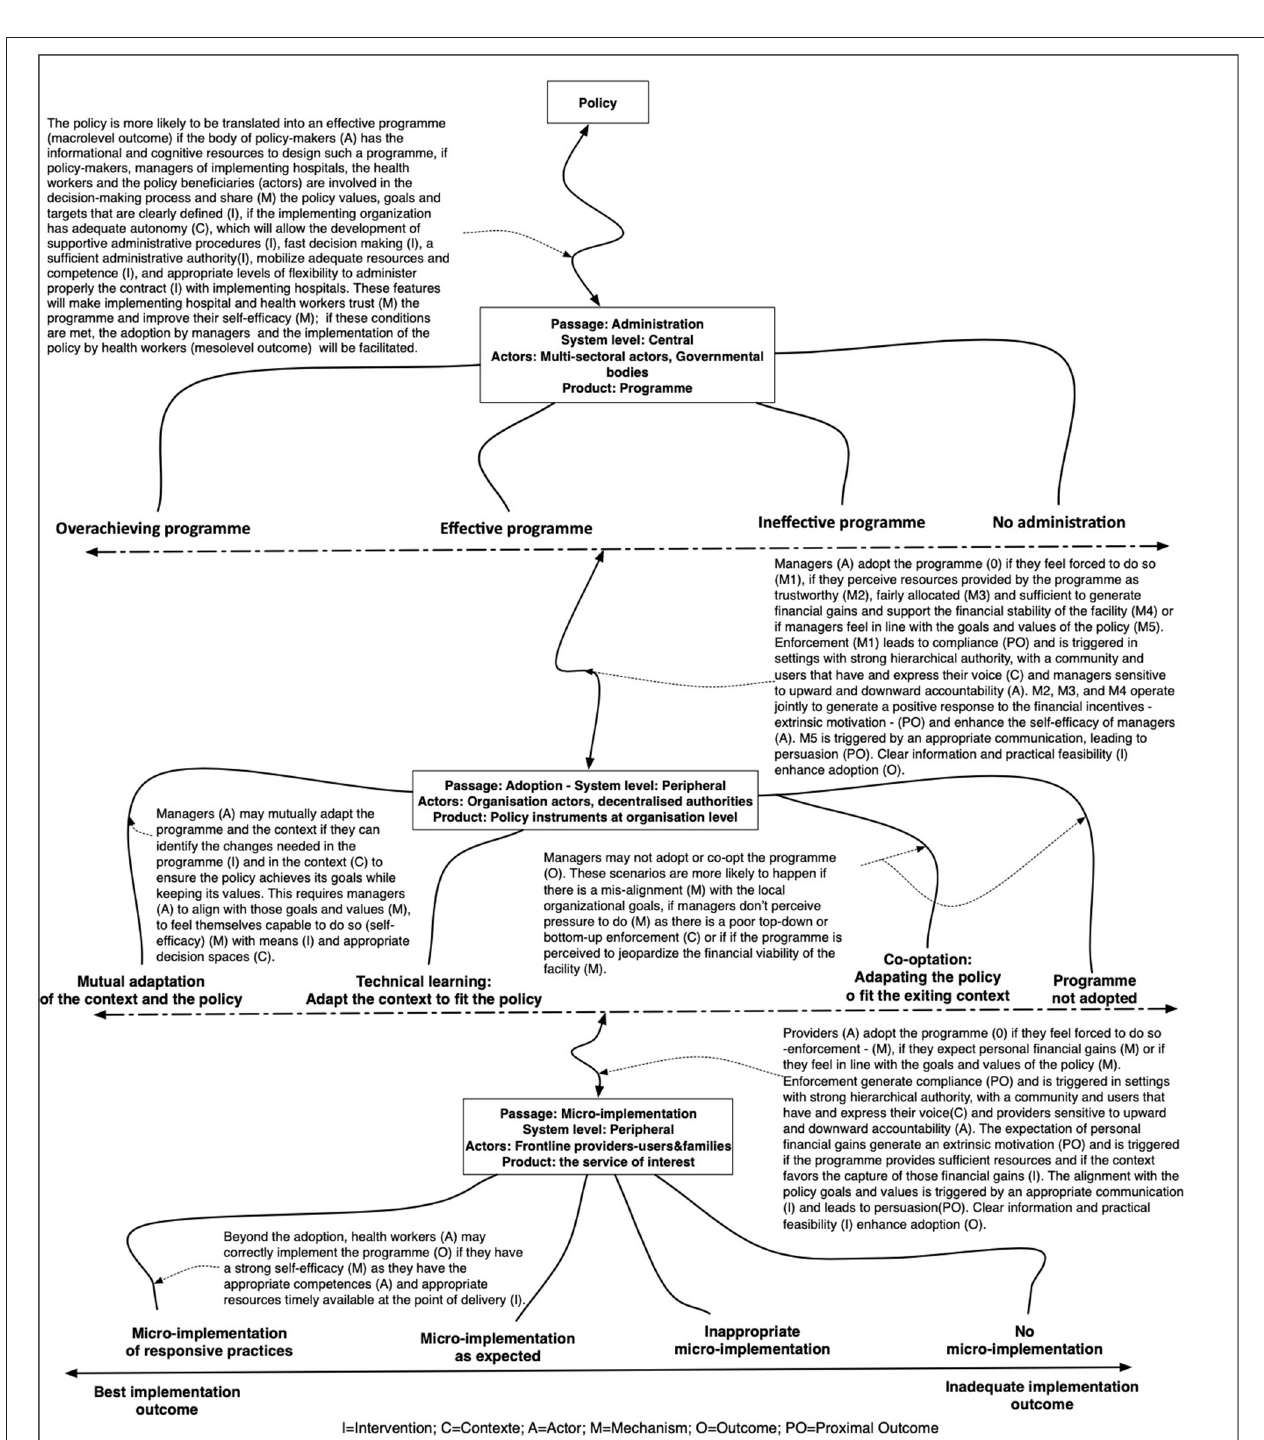
FIGURE 2 | The initial programme theory.